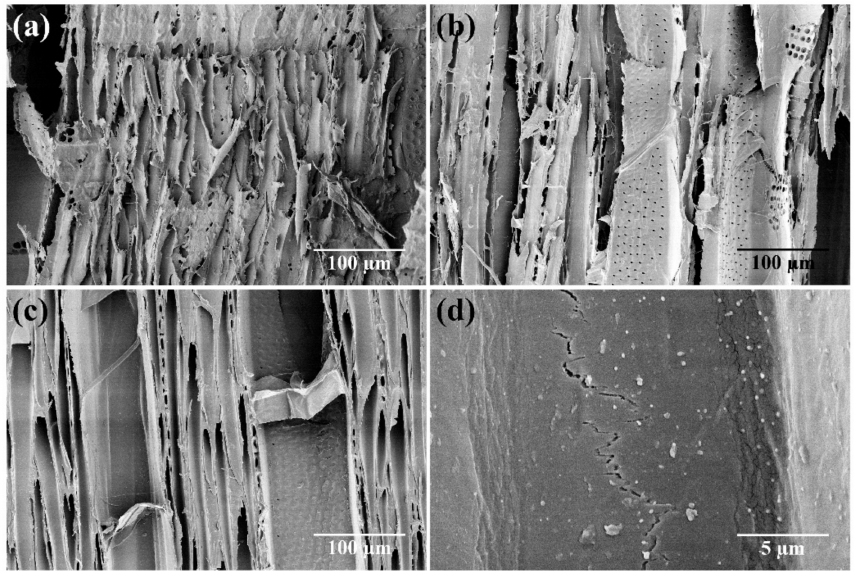
Figure 2. SEM images of wood samples after 16 weeks of exposure to T. versicolor : ( a ) control samples, ( b ) samples treated with propolis (40 mg / mL), ( c ) samples treated with silver nanoparticles (20 ppm), and ( d ) zoomed-in view of silver nanoparticles on the cell